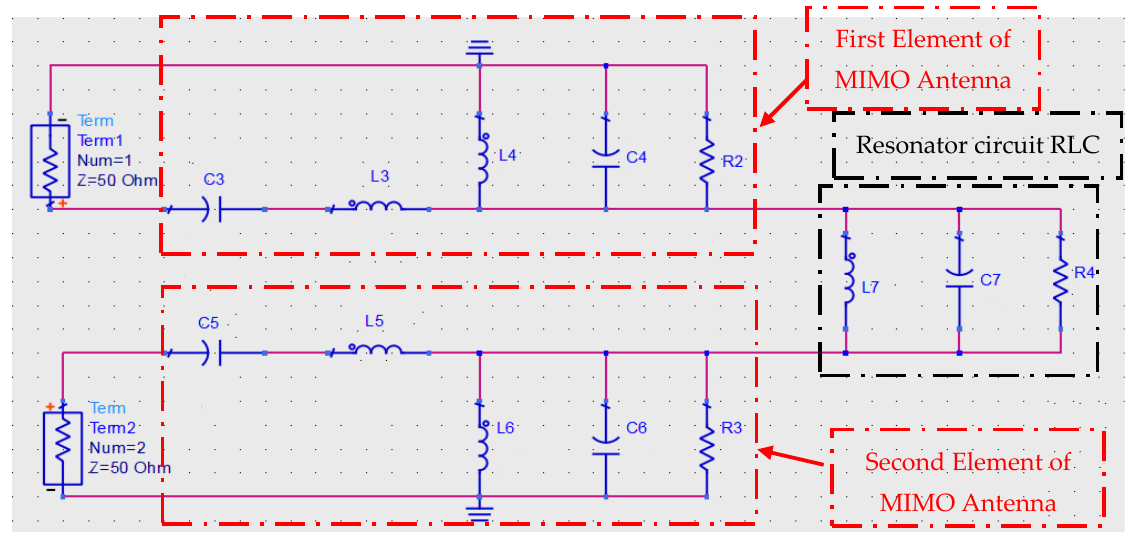
Figure 20. Equivalent circuit model of the proposed structure of two-element MIMO configurations with the MTM unit cell.